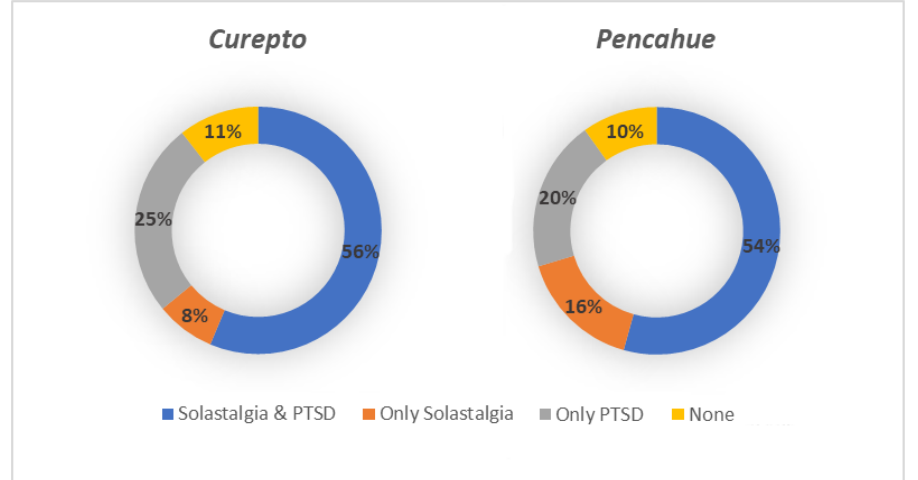
Figure 7. Percentage distribution of solastalgia and PSDT cases by location.